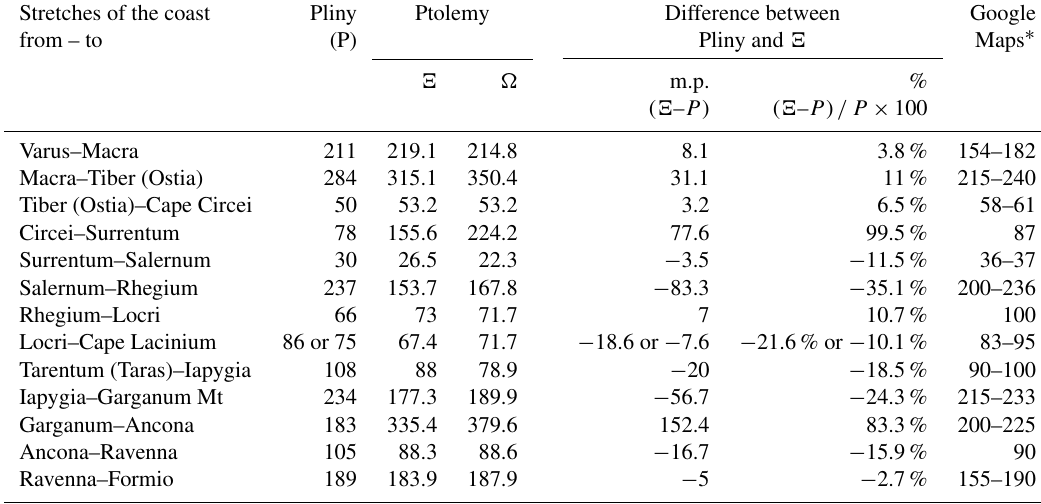
Table 2. Comparison of the distances along the coast of Italy according to Pliny, Ptolemy, and measurements using Google Maps (Google Inc., 2017). All distances are expressed in terms of Roman miles; 1m.p. = 1480m. Stretches of the coast Pliny Ptolemy Difference between Google from – to (P) Pliny and (cid:52) Maps ∗ (cid:52) (cid:127) m.p. % ( (cid:52) – P ) ( (cid:52) – P ) /P ×